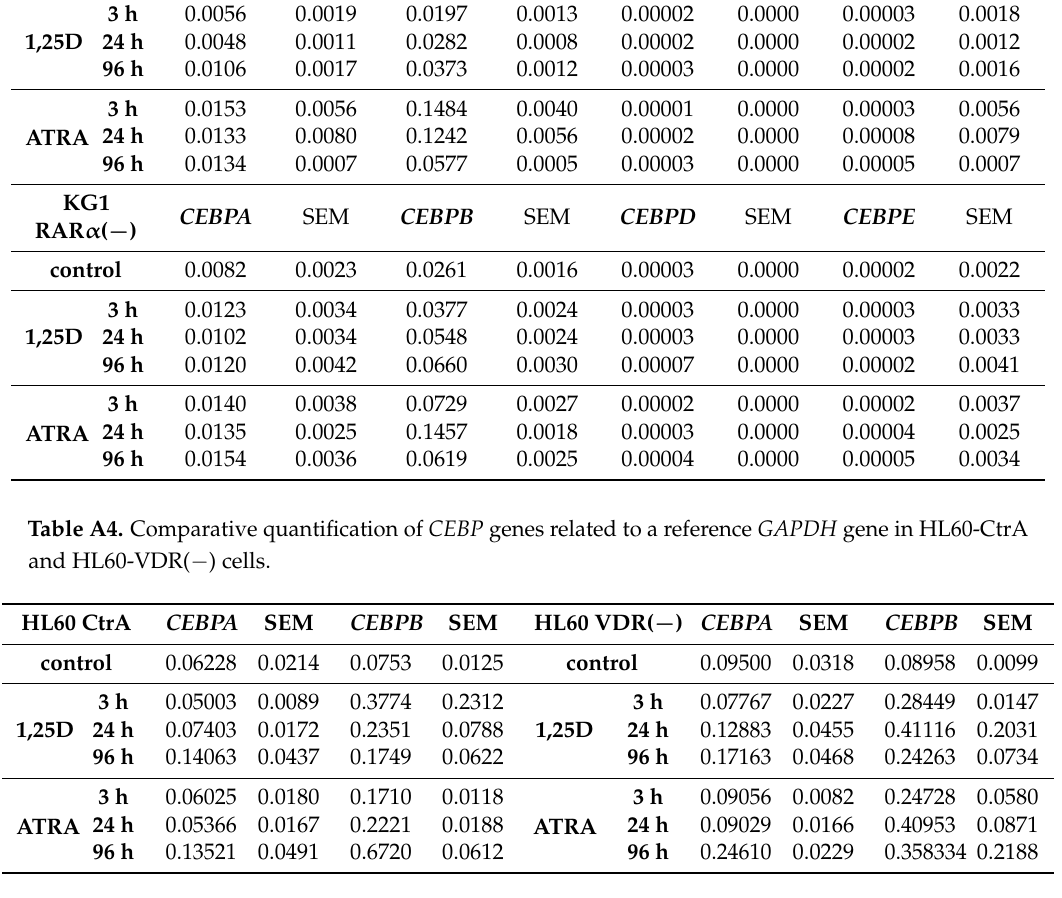
Table A5. Comparative quantification of VDR and RARA genes related to a reference GAPDH gene in all cell lines used in this